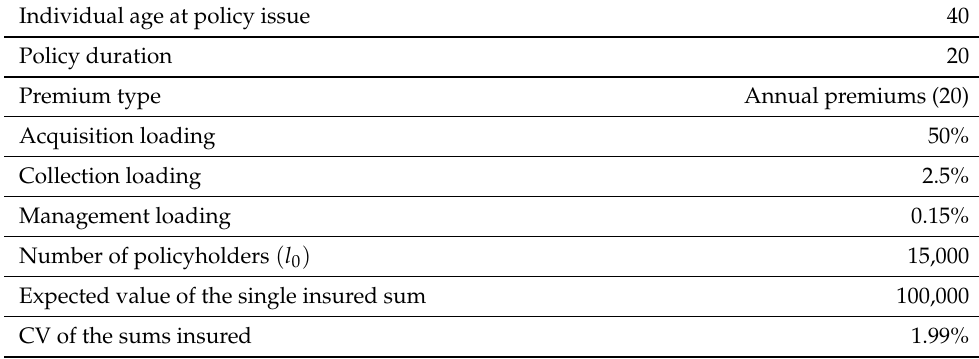
Table 2. Model parameters.